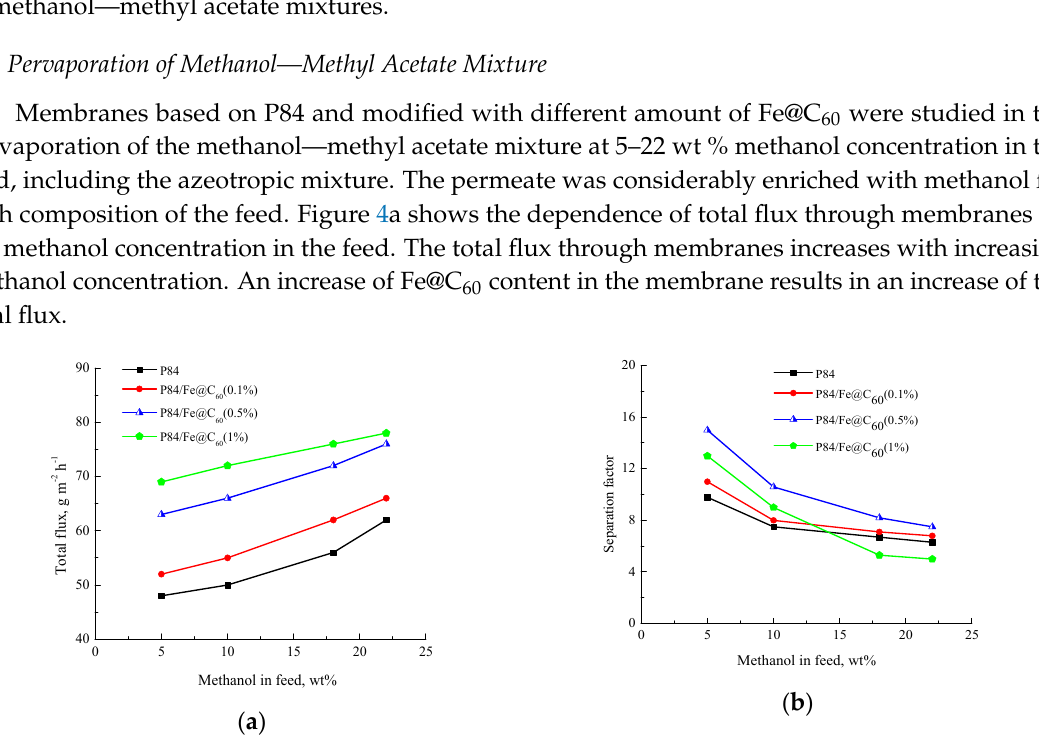
1 Figure 5. Dependence of the pervaporation separation index (PSI) on Fe@C 60 content in the membrane in the pervaporation of the methanol—methyl acetate (18:82 wt %) azeotropic mixture, 25 ° С . Modern scientific literature recommends describing the transport properties of membranes in pervaporation processes, not only in terms of flux and separation factor, but also in terms of selectivity and permeability [44,45]. The calculation of permeability and selectivity makes it possible to exclude the driving forces of the separation process (partial vapor pressure) and to reveal the characteristic properties of the membrane–penetrant system. The permeabilities of individual substances (methanol and methyl acetate) and selectivity β МеОН / М eO А c for the original P84 membrane and the best modified Р 84/Fe@ С 60 (0.5%) membranes were calculated according to the procedures described by Baker et al. [35]. Figures 6 and 7 present these parameters in comparison with the data on the flux and separation factor for the P84 and P84/Fe@C 60 (0.5%) membranes.